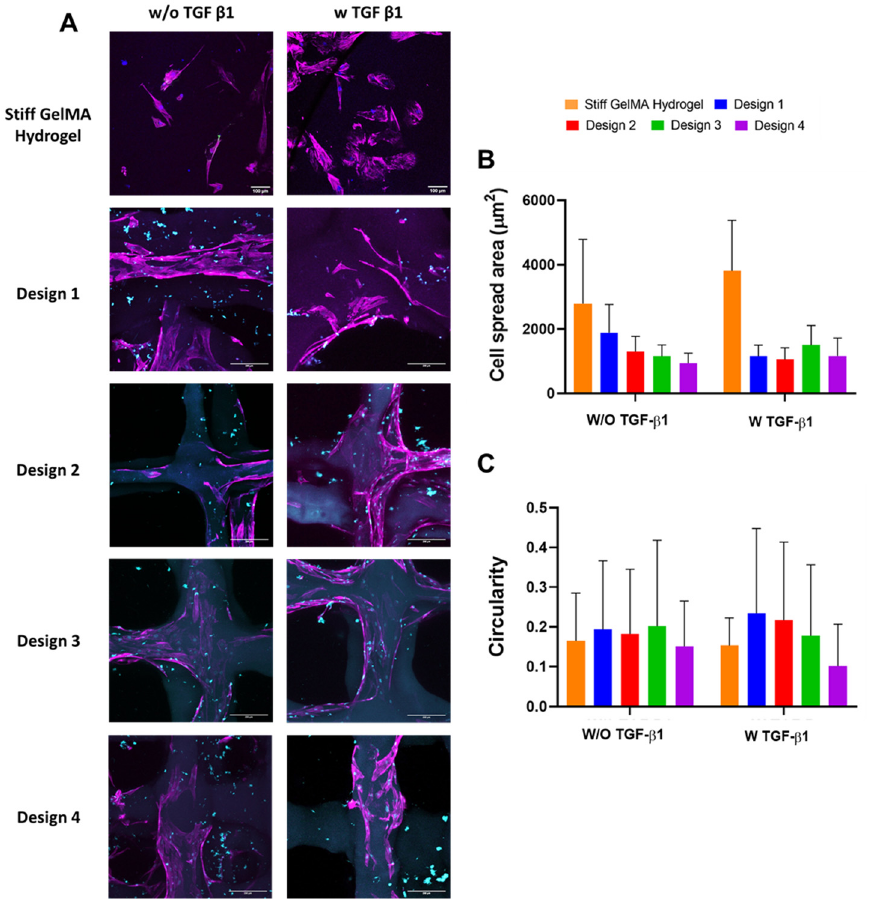
Figure 8. Effect of porous architecture of different 3D-printed scaffold designs on fibroblast infiltration and morphology ( A ), cell spread area ( B ) and circularity ( C ). DAPI (blue) and phalloidin (purple). Scale bar = 100 µm.